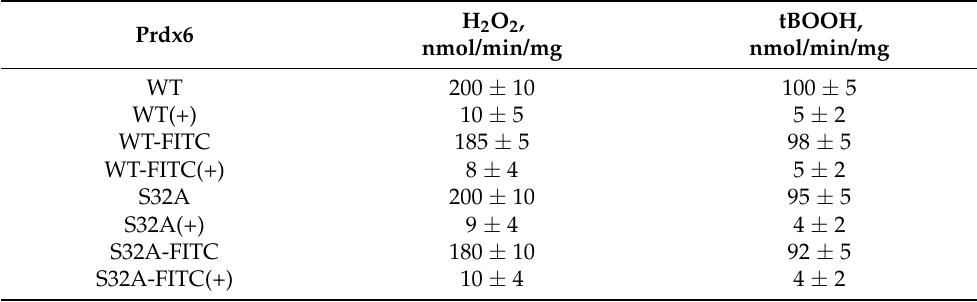
Figure 2. The SDS-PAGE of FITC-labeled proteins used in the study: 1–Prdx6 WT; 2–Prdx6 WT(+); 3–Prdx6-S32A; 4–Prdx6-S32A(+); 5–BSA; 6–BSA(+). ( a ) Coomassie R250 staining; ( b ) UV fluorescence of labeled proteins (iBright, Thermo, USA). Table 1. Peroxidase activity of Prdx6: wild-type (WT) and mutant (S32A) forms labeled with FITC and overoxidized with 2 mM H 2 O 2 (+).